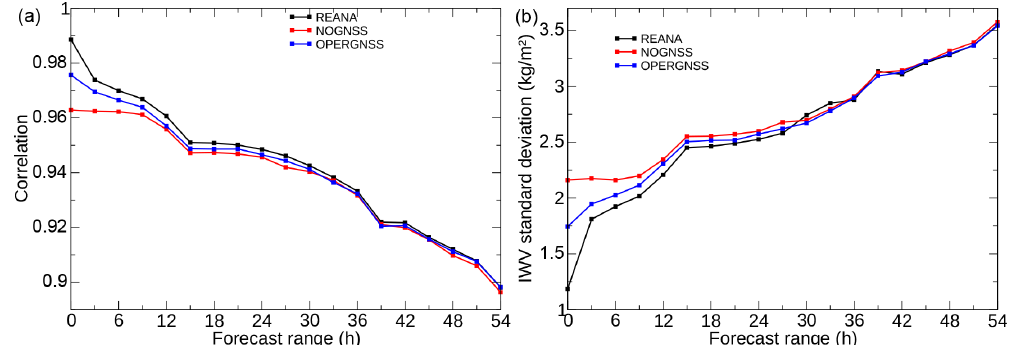
Figure 7. Correlation (a) and standard deviations ( b , kgm − 2 ) of integrated water vapour content between AROME-WMED forecasts and reprocessed GNSS observations (Bock et al., 2016) as a function of forecast range (h).